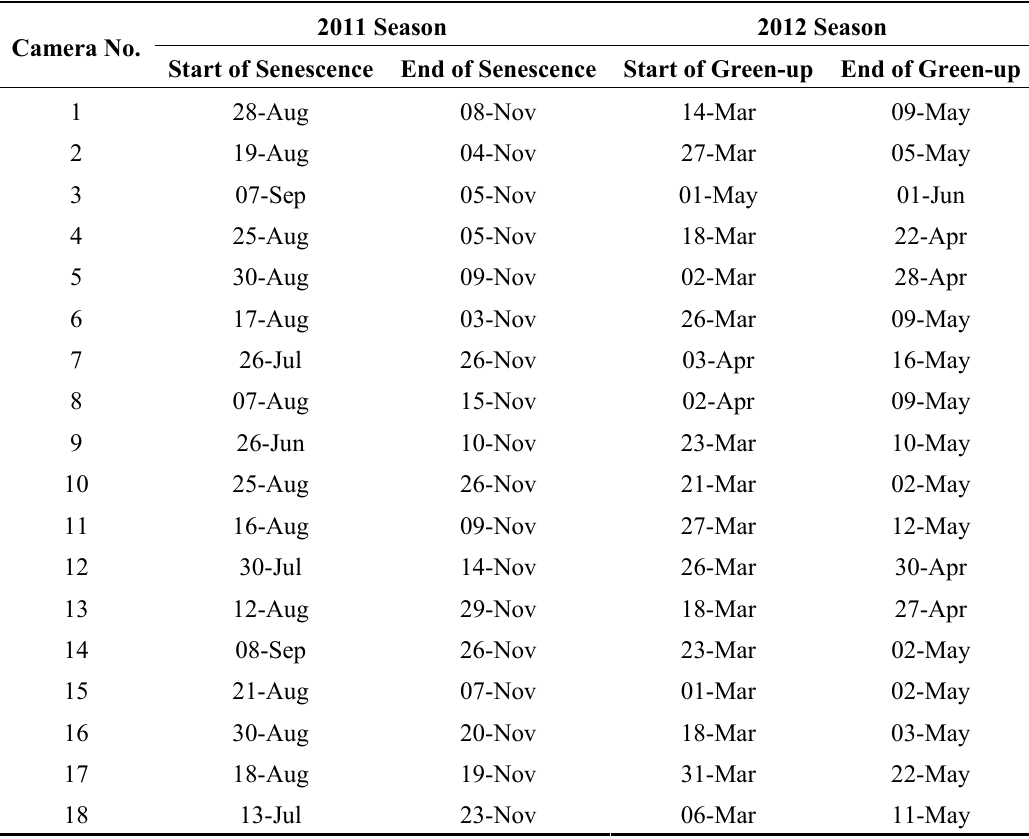
Table 3. Automatically calculated phenological dates for the cameras that are shown Figure 1. Camera